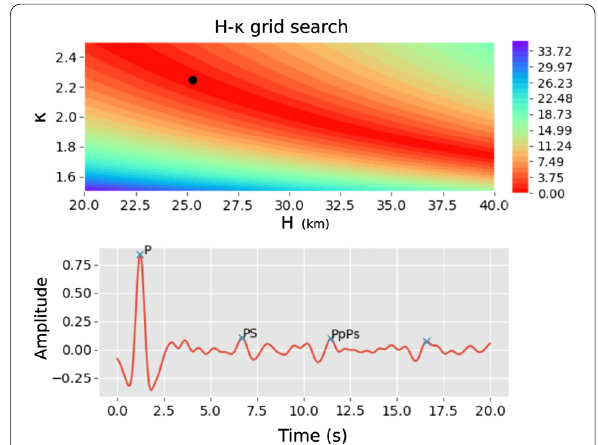
Fig. 5 (Bottom) Stack of all receiver function for station ZF-MAYE (orange line) and automatically picked phases (blue cross and their name in black font). (Top) H – κ grid search following Zhu